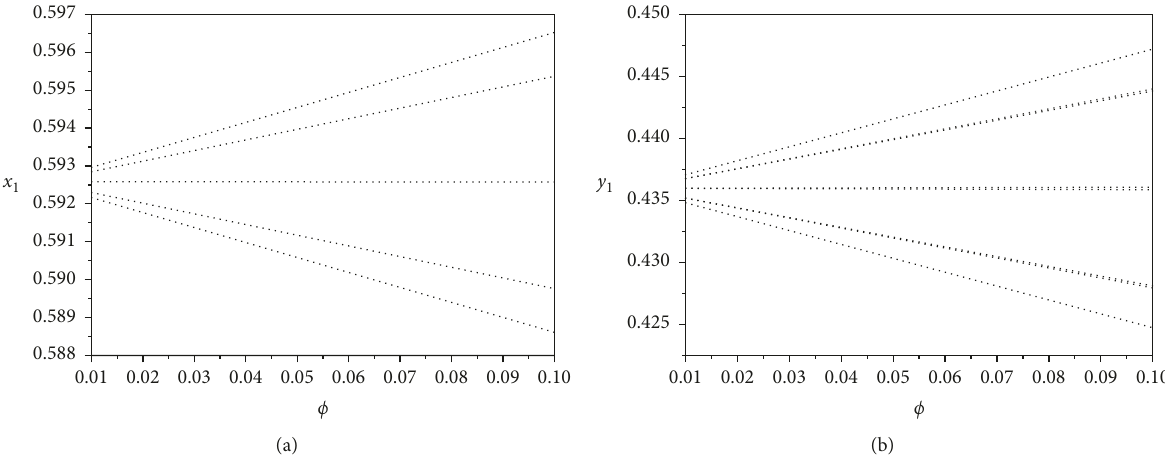
Figure 17: ω � 1.20 and η � 0.650: (a) displacement response; (b) frequency spectrum; (c) rotor orbit; (d) Poincar´e maps.